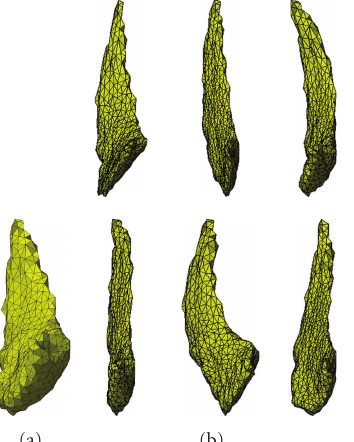
Figure 1: Random deformation of a template caudate surface (left). The six surfaces following the template are independent realization of the model described in